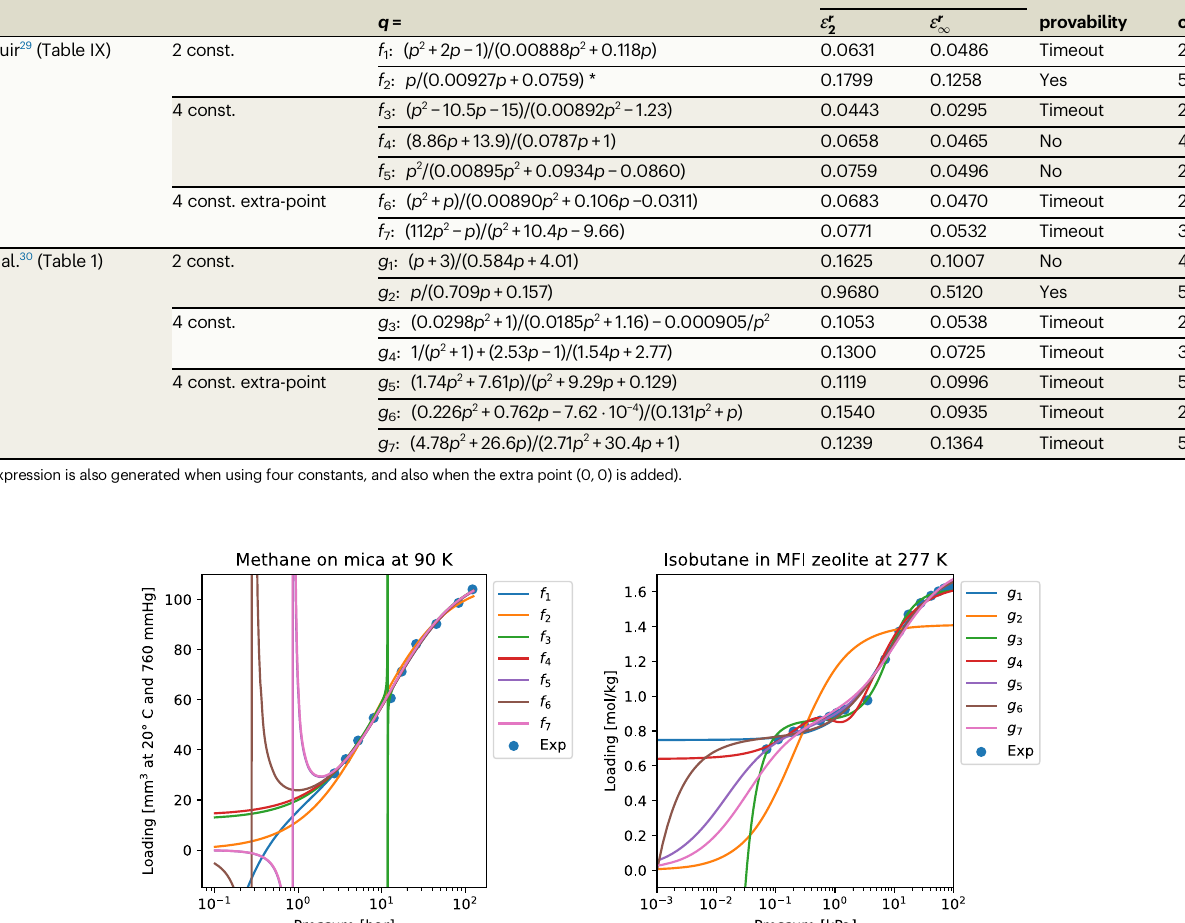
Table 3 | Results on two datasets for the Langmuir problem Data Condition Candidate formula Langmuir 29 (Table IX)